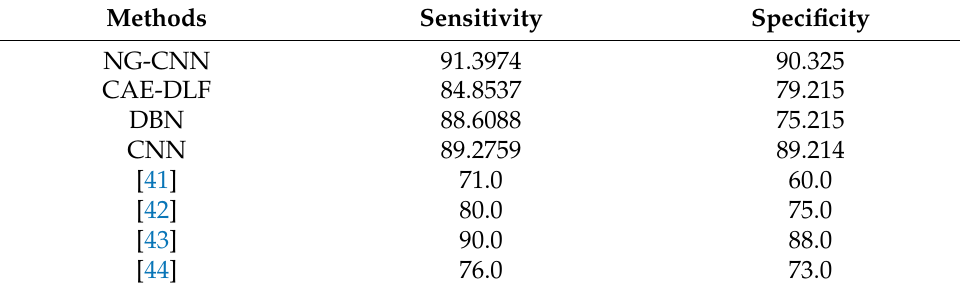
Table 3. Performance summary of NG-CNN with existing